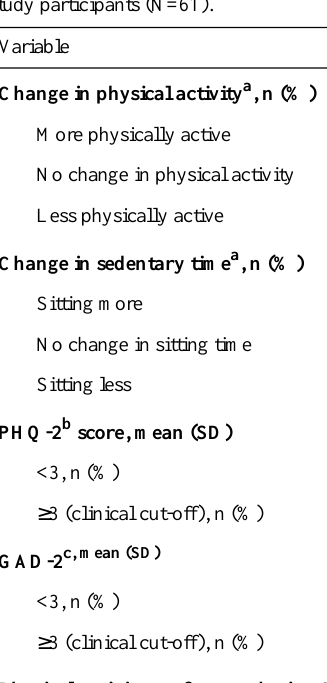
Table 2. Changes in physical activity and sedentary time, mental health evaluation, and preferences for physical activity and social support among the study participants